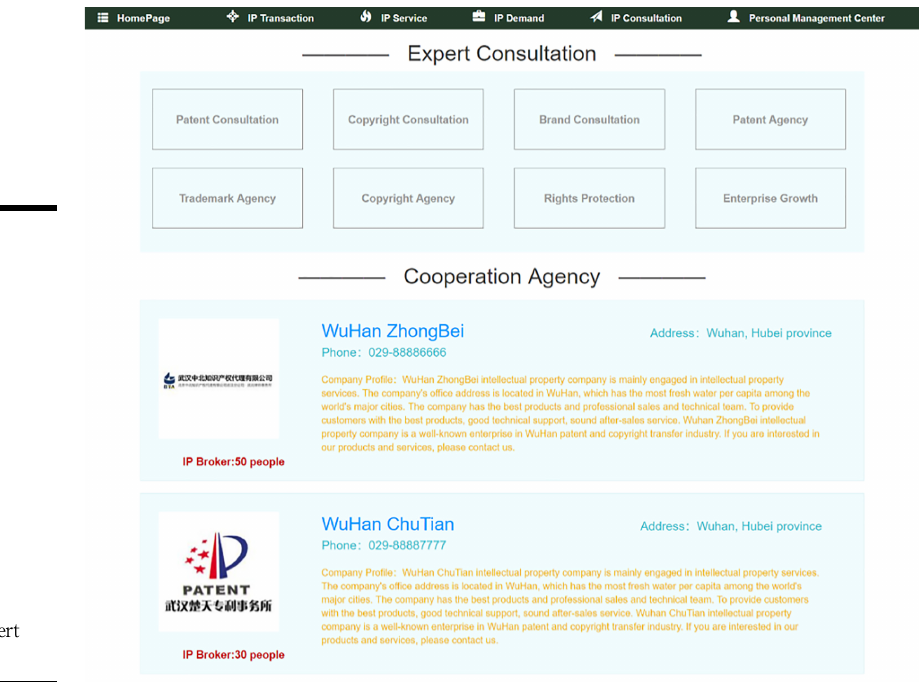
Figure 12. Interface of expert support